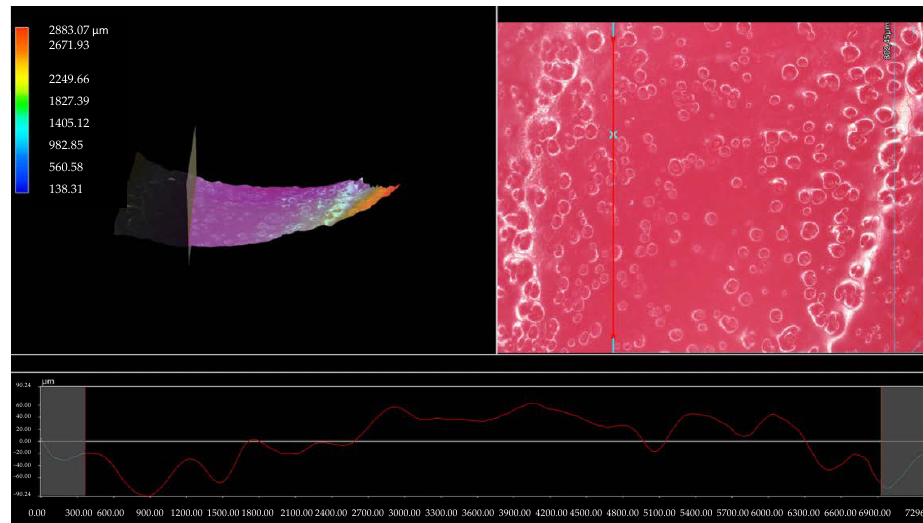
Figure 3. 3D view and the roughness profile (along the red line) of sample 575/7.5.